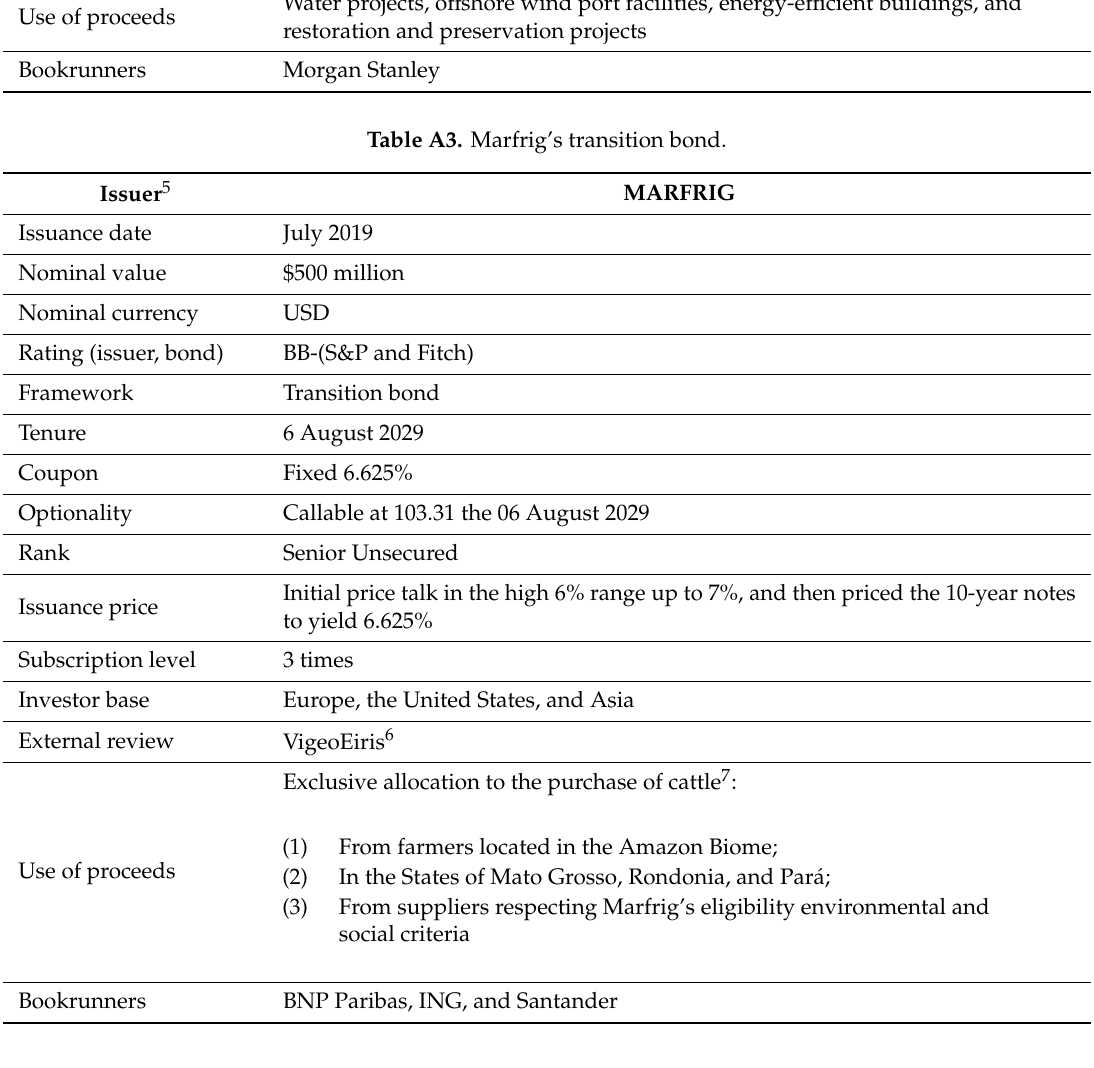
Table A3. Marfrig’s transition